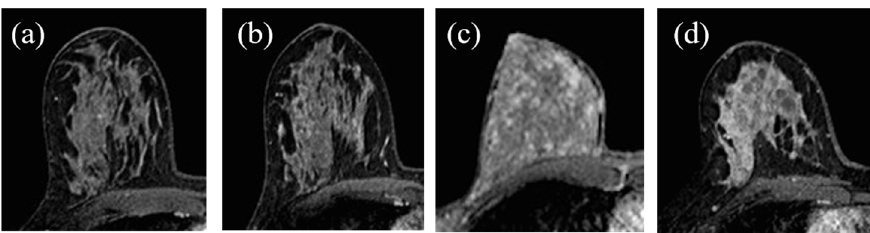
Figure 2. Background parenchymal enhancement (BPE): ( a ) minimal; ( b ) mild; ( c ) moderate; ( d ) marked.